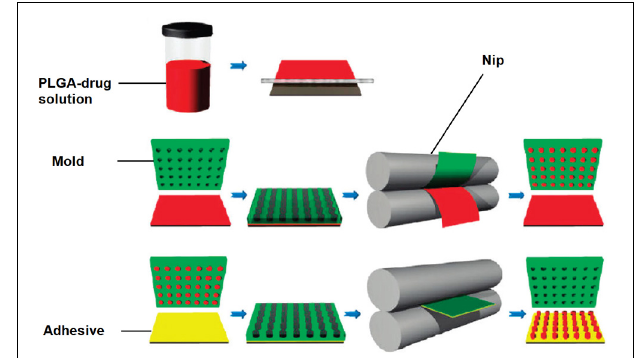
FIGURE 10 | Schematic showing PRINT procedure, reprinted with permission from Perry et al. (2011). Copyright (2019). American Chemical Society.